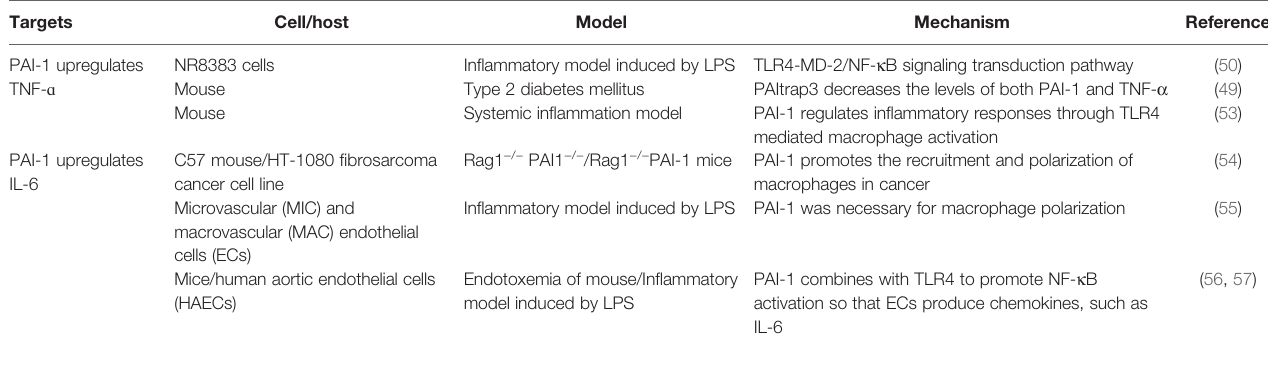
TABLE 4 | PAI-1 upregulate the expressions of IL-6 and TNF- a .